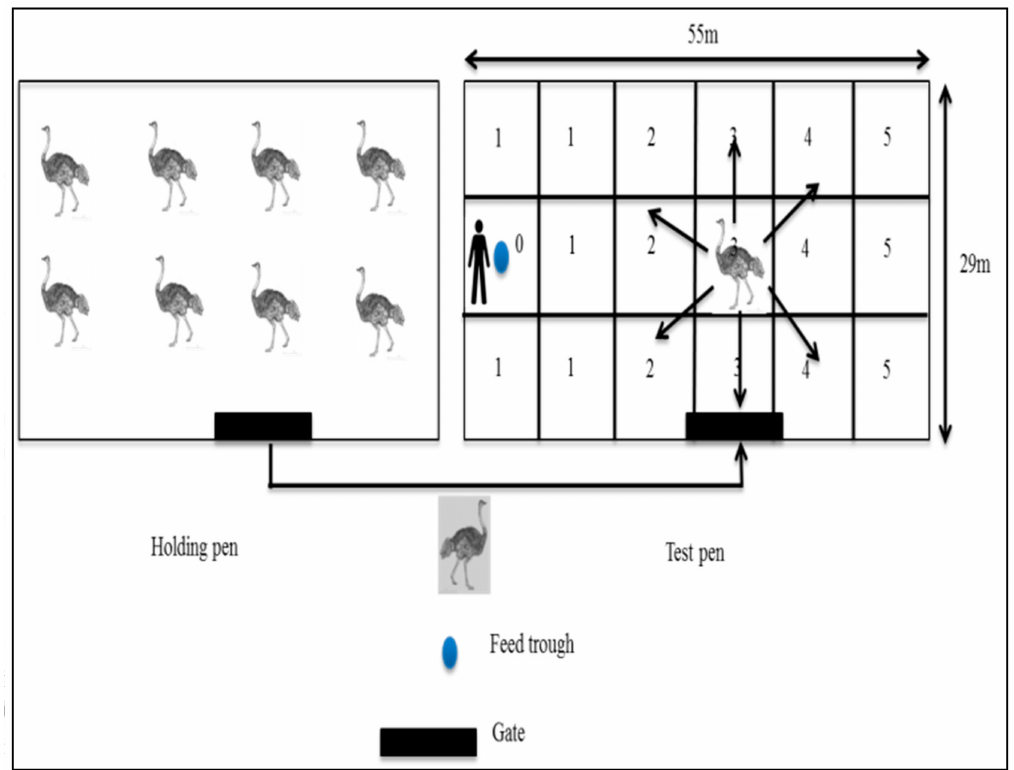
Figure 2. Experimental procedure of the fear test showing the holding pen (with the peers) and the test pen (divided into 18 equal squares). One bird was randomly selected from the holding pen and taken to the test pen and its movement was recorded during three different phases. Phase 1: 1 min; no human present in the test pen. Phase 2: 1 min; human introduced food and walk out of the test pen. Phase 3: 2 min; food and human present in the test pen (human offering food to the